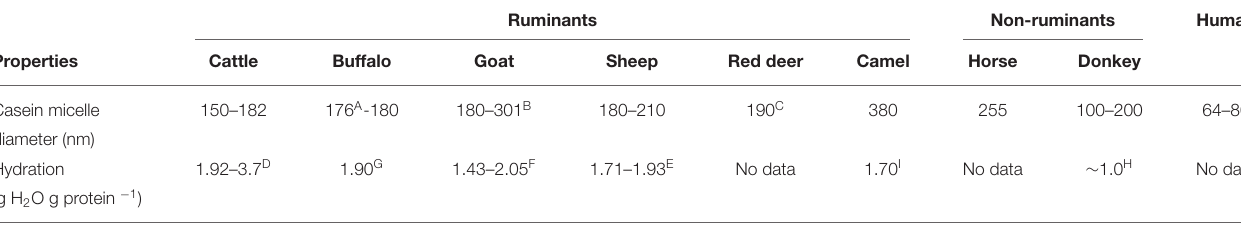
TABLE 3 | Casein characteristics of milk from different mammalian species #